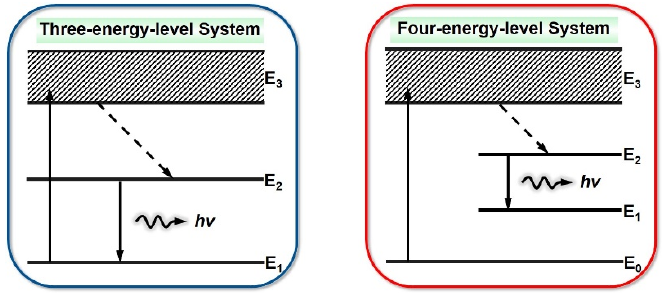
Figure 5. Energy level diagram of three-level laser materials and four-level laser materials.